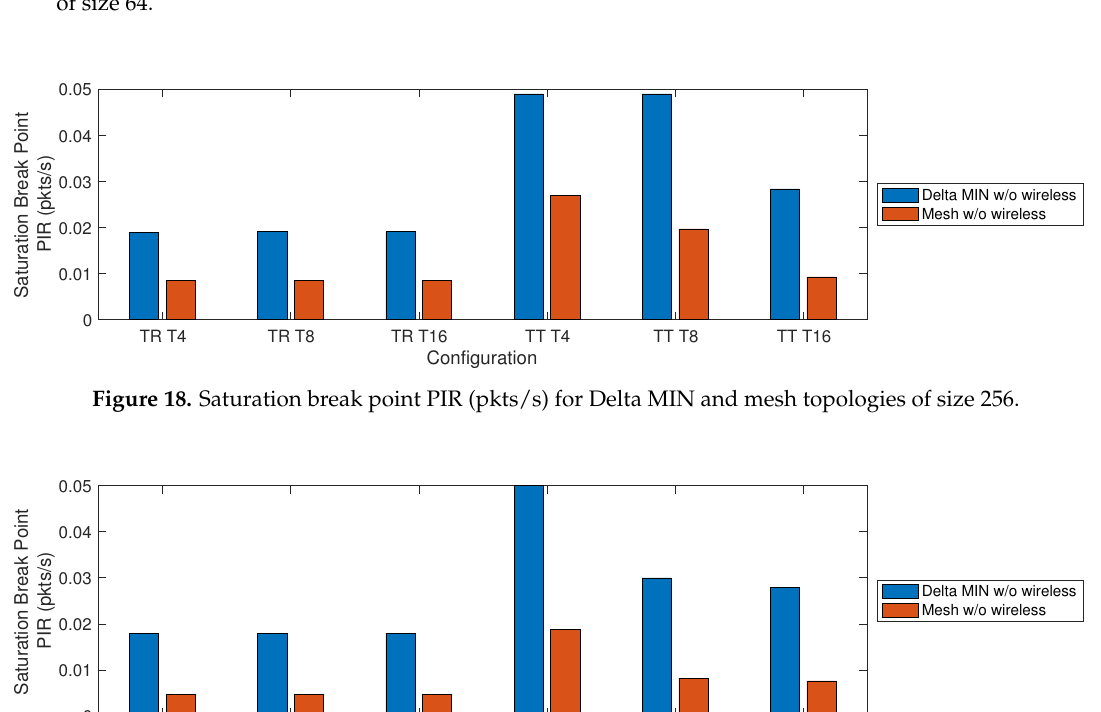
Figure 17. Saturation break point packet injection rate (PIR) (pkts/s) for Delta MIN and mesh topologies of size 64.